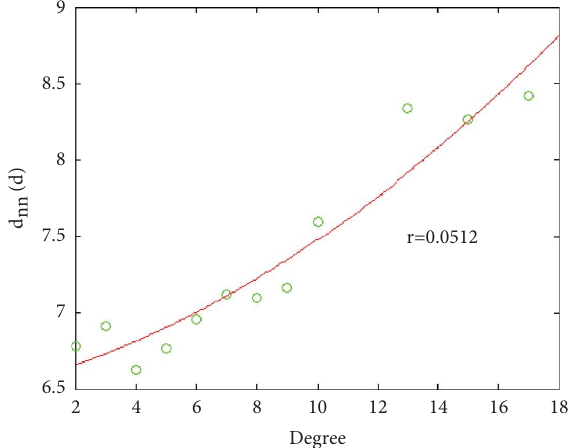
Figure 12: Te changes of d